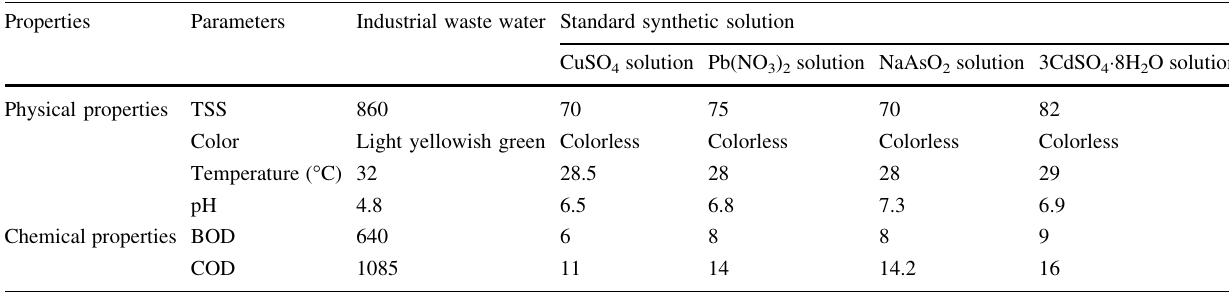
Table 1 Initial physical and chemical characteristics of industrial waste water and standard synthetic solution